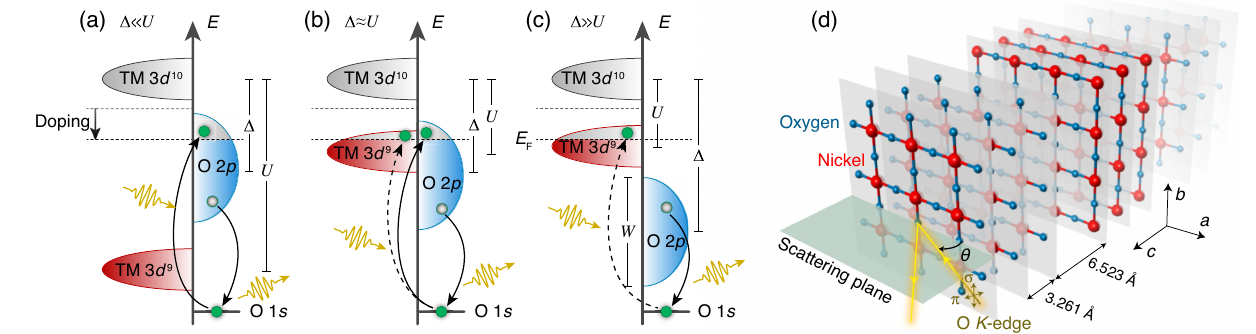
FIG. 1. Schematic of the O K -edge RIXS process. (a) – (c) RIXS processes for different values of the Hubbard U and charge-transfer energy Δ . These are defined as the energy cost of specific atomic transitions in the material: for a d 9 ground state, U being a → d 8 → d 10 d 9 d 9 d 10 L transition, where i and j label TM sites and L denotes an oxygen ligand hole. For a charge- and Δ being a d 9 i j i i j i transfer insulator ( Δ ≪ U ), the doped holes are mostly in the oxygen 2 p orbitals, while in a Mott-Hubbard insulator ( Δ ≫ U ), the doped holes mainly occupy the TM 3 d n state. In the mixed charge-transfer – Mott-Hubbard regime ( Δ ∼ U ), the doped holes are spread among both the TM and oxygen sites. Arrows show examples of x-ray transition pathways, which, because of x-ray dipole selection rules, can involve either O states or TM-O hybridized states, making this process ideal to distinguish situations (a) – (c). Note that W is the band width for oxygen 2 p orbitals, and E is the Fermi energy (marked by the horizontal dashed lines). (d) Experimental setup for RIXS F measurements at the O K edge and crystal structure of La 4 Ni 3 O 8 . Only the nickel and oxygen ions in the trilayers are